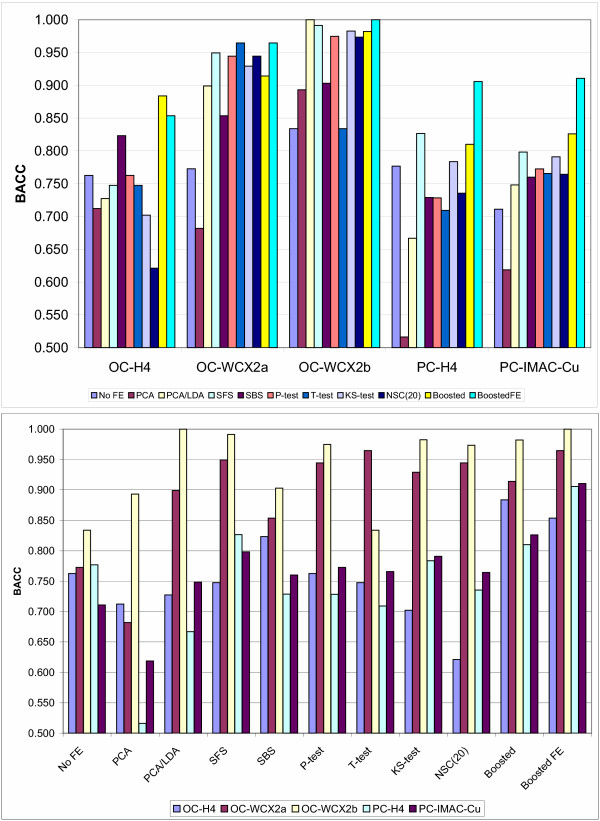
Performance of Feature Extraction Algorithms on five cancer data sets. Both graphs show balanced accuracy (BACC) score. Top: Results grouped by data set. Bottom: Results grouped by feature extraction algorithm.